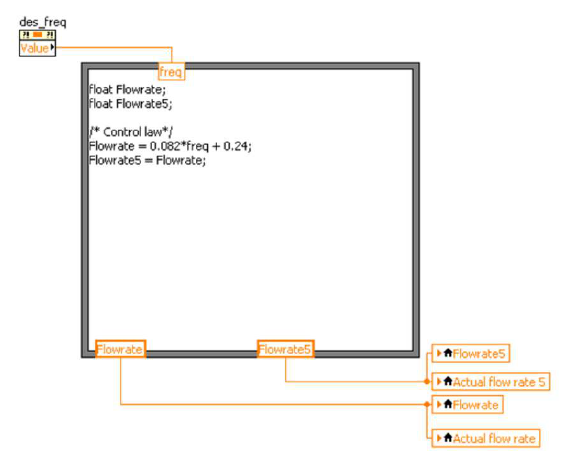
Figure 9. The Labview schematic for the module that implements the Control Law